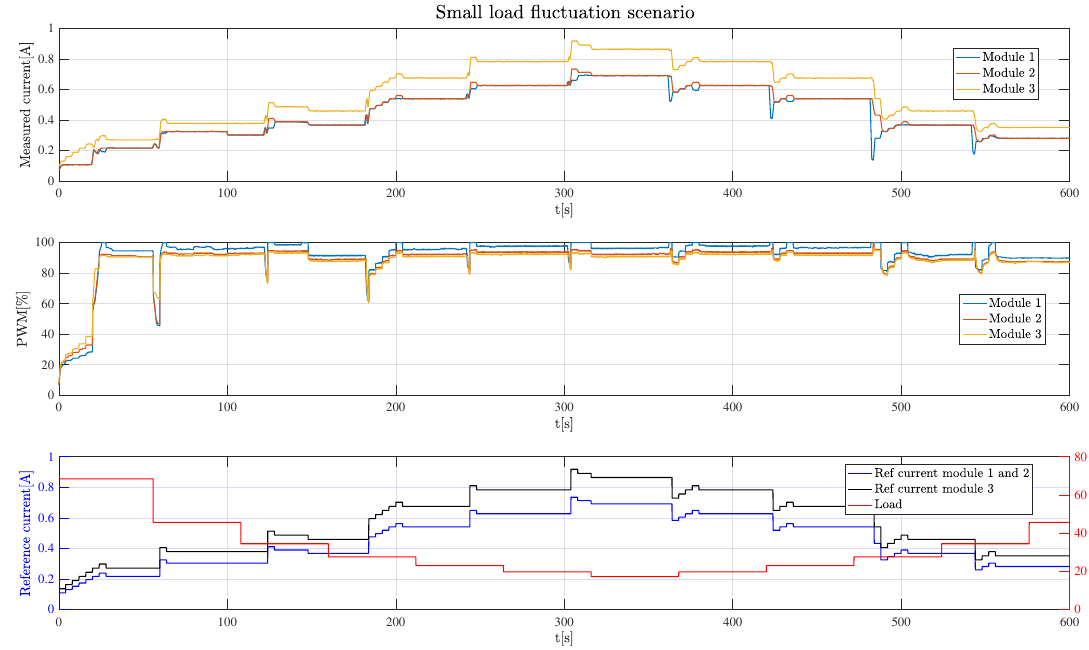
Figure 11. Currents ( top ) and modulation of battery voltages ( middle ) in battery modules for autonomous module current scheduling of three parallel placed battery modules with different battery capacity, reference current and time-varying external load impedance ( bottom ) under small load fluctuation